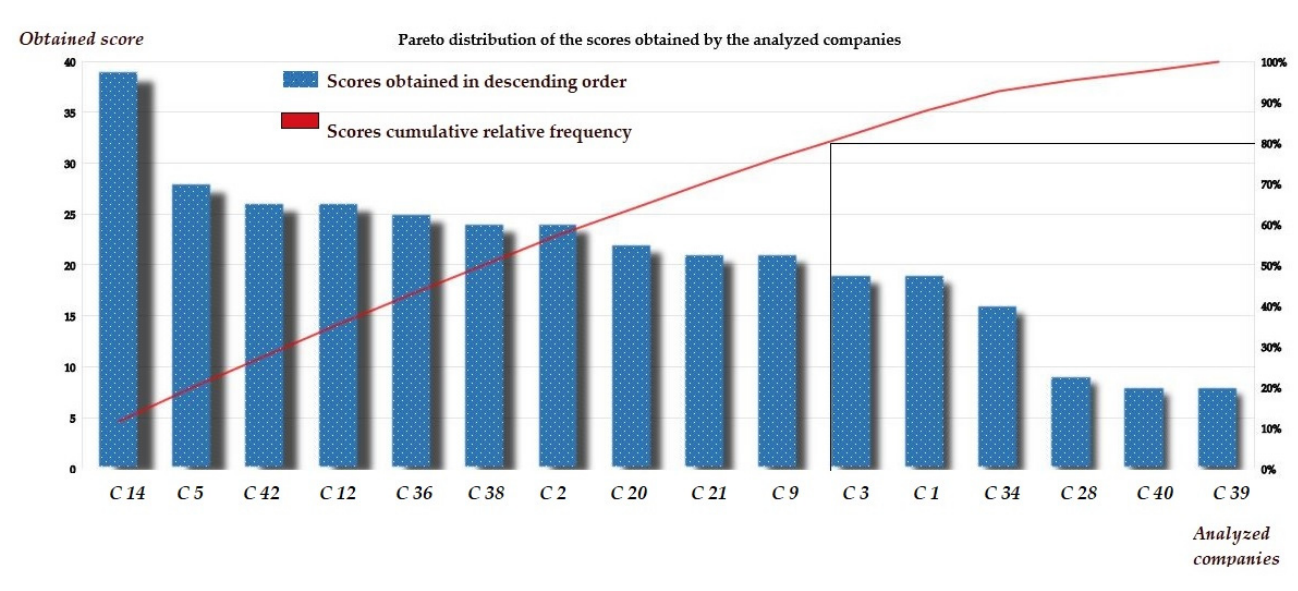
Figure 7. Pareto distribution of the relative cumulative frequency of the scores (Authors’ own source).